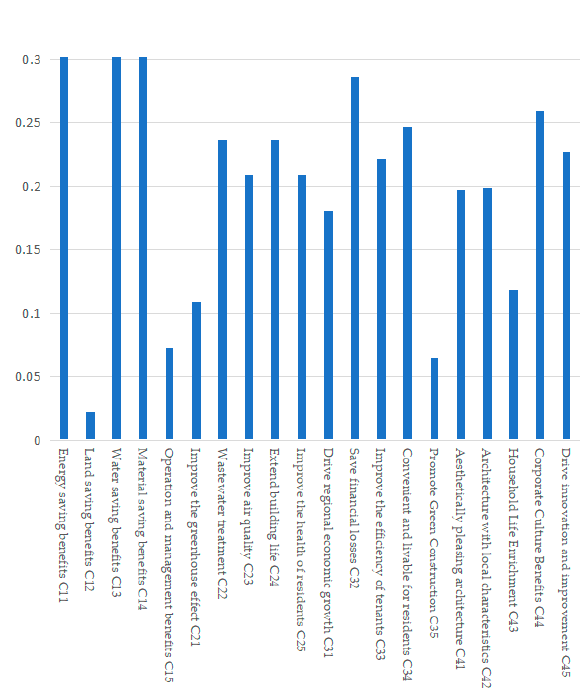
Figure 1. Comparison of weights of indicators.